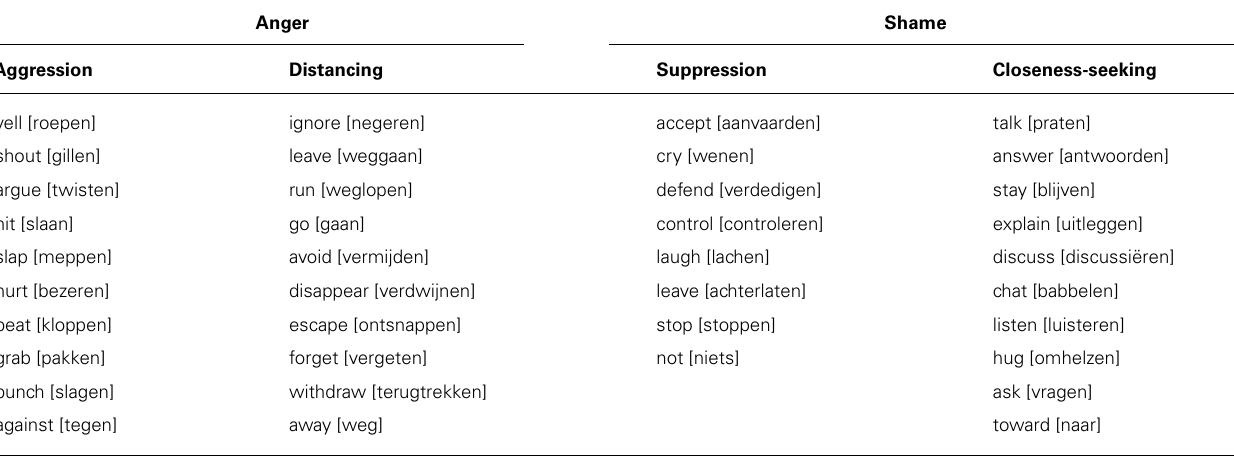
Table 1 | Selected cue words that reflected the predicted emotional responses in Belgium and the Unites States. Anger Shame Aggression Distancing